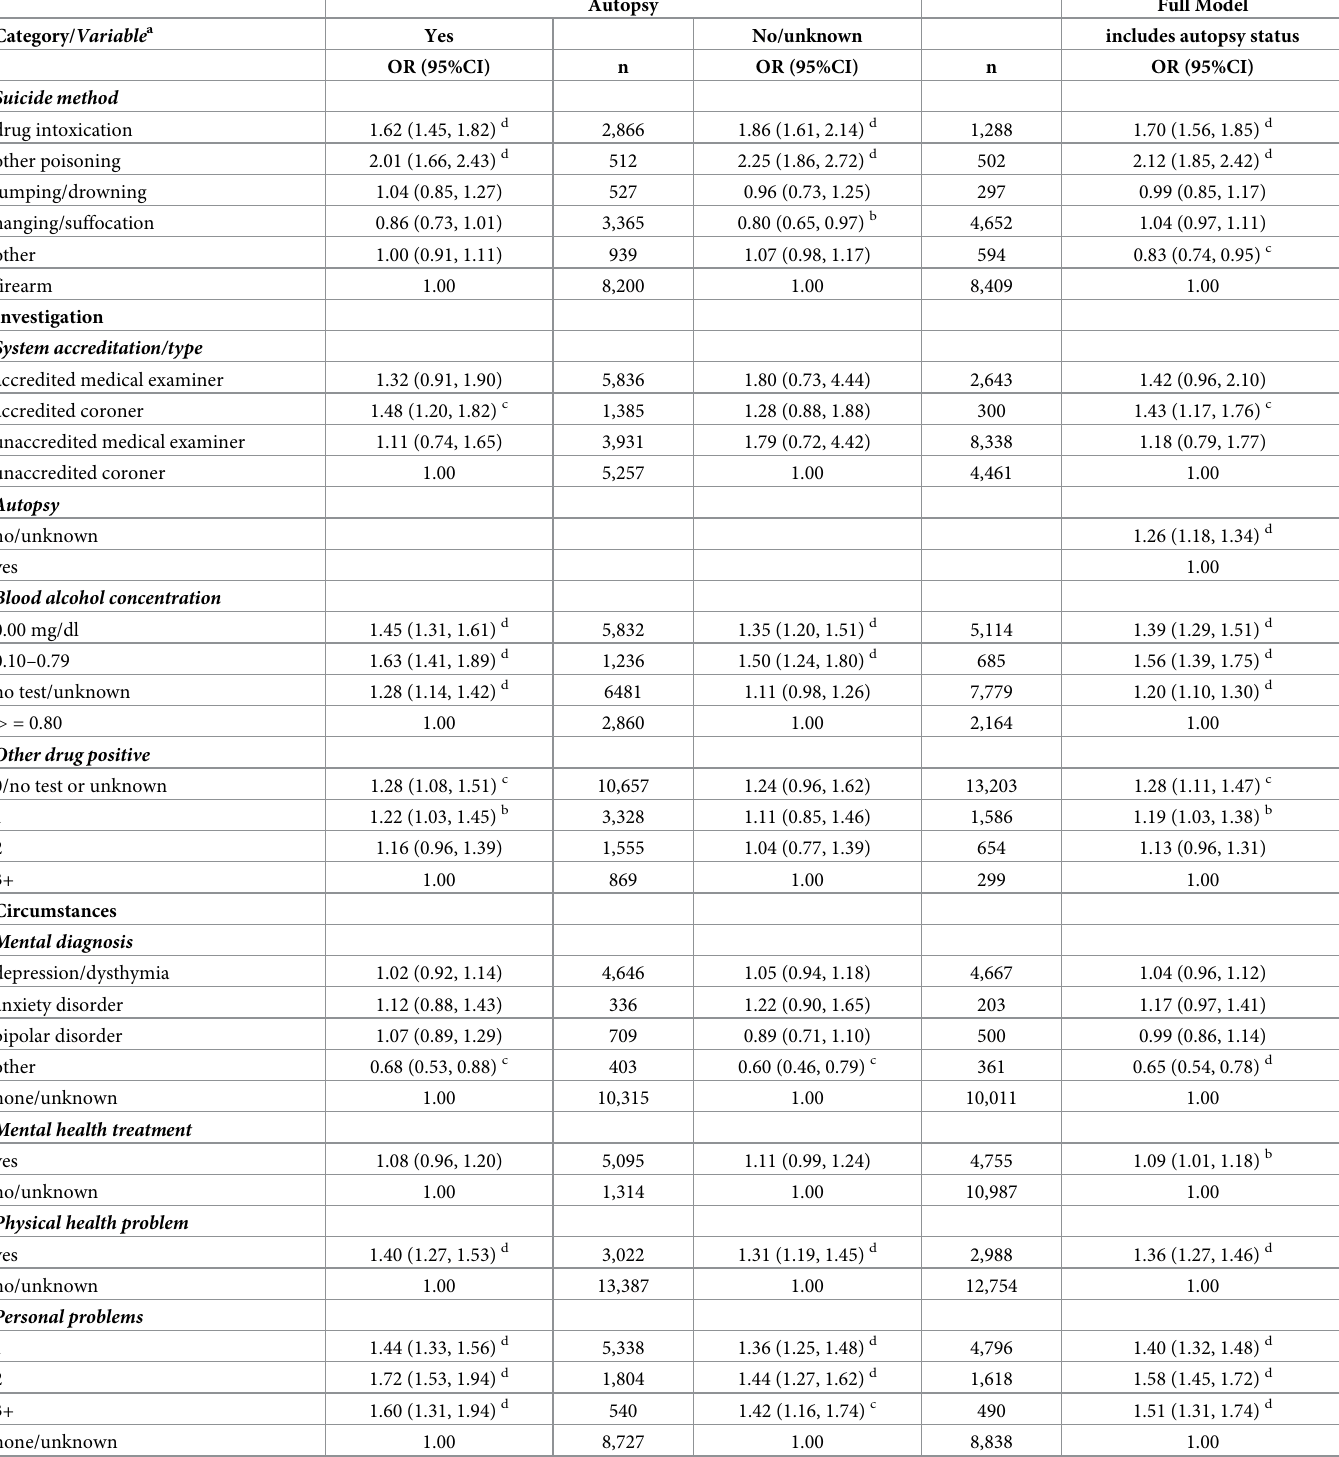
Table 4. Odds ratios and 95% confidence intervals for an evidentiary note by suicide method, stratified by autopsy status and unstratified, adjusted for investiga- tion characteristics, death circumstances, and demographics, 17 National Violent Death Reporting System States, 2011–2013. Autopsy Full